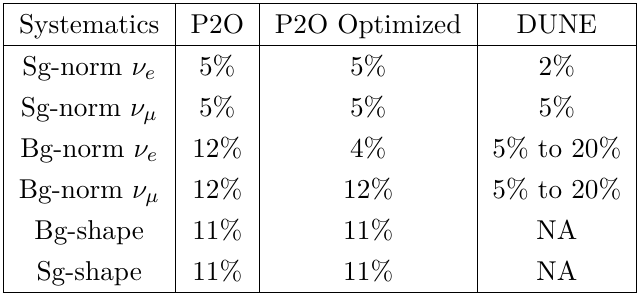
Table 1 . The values of systematic errors that we considered in our analysis. “norm” stands for normalization error, “Sg” stands for signal and “Bg” stands for